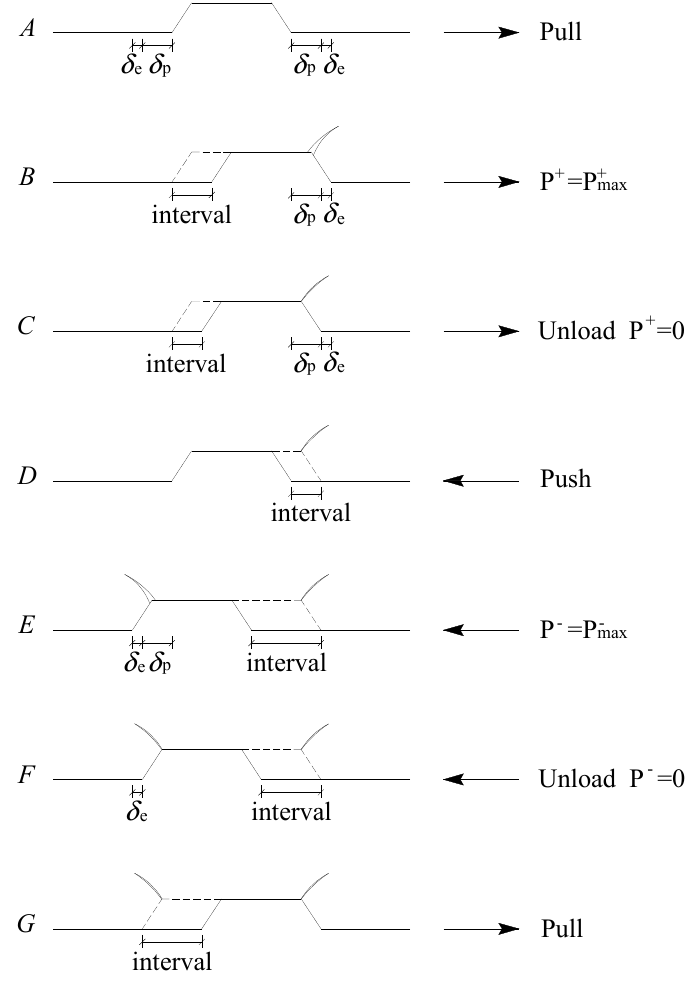
δ δ are the and e p